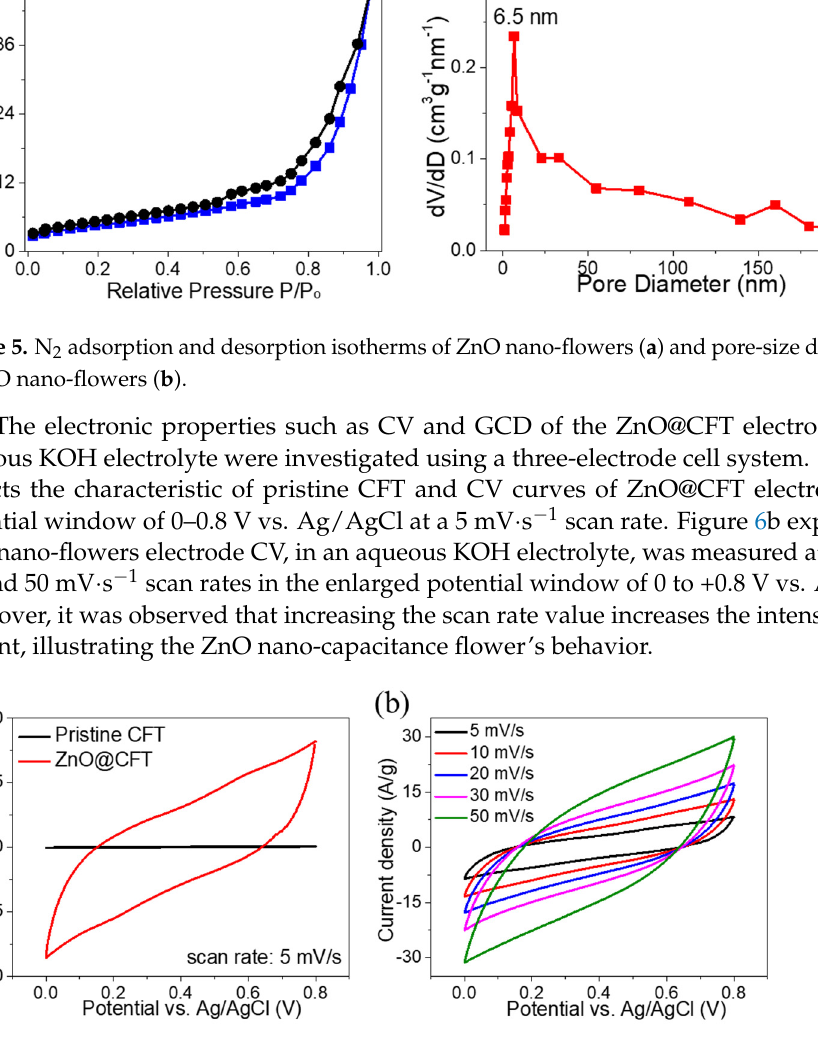
Figure 6. Electrochemical characterizations of ZnO@CFT electrode in an aqueous electrolyte of KOH: ( a ) ZnO@CFT and pristine CFT electrodes CV curves are compared ( b ) CV curves for ZnO@CFT